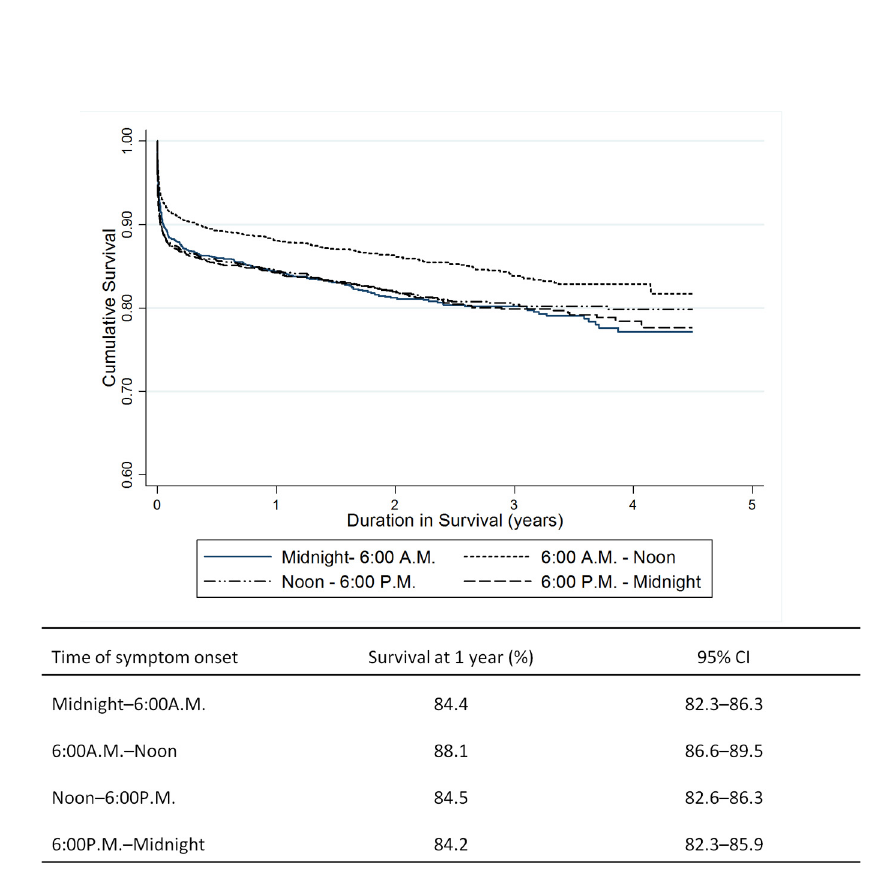
Fig 5. Long-term survival as a function of time of symptom onset. Survival curves out to 4.5 years of follow up shown above and Kaplan-Meier estimates of 12-month survival shown below.